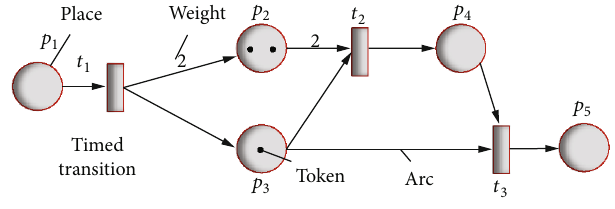
Figure 4: Representation of the SPN